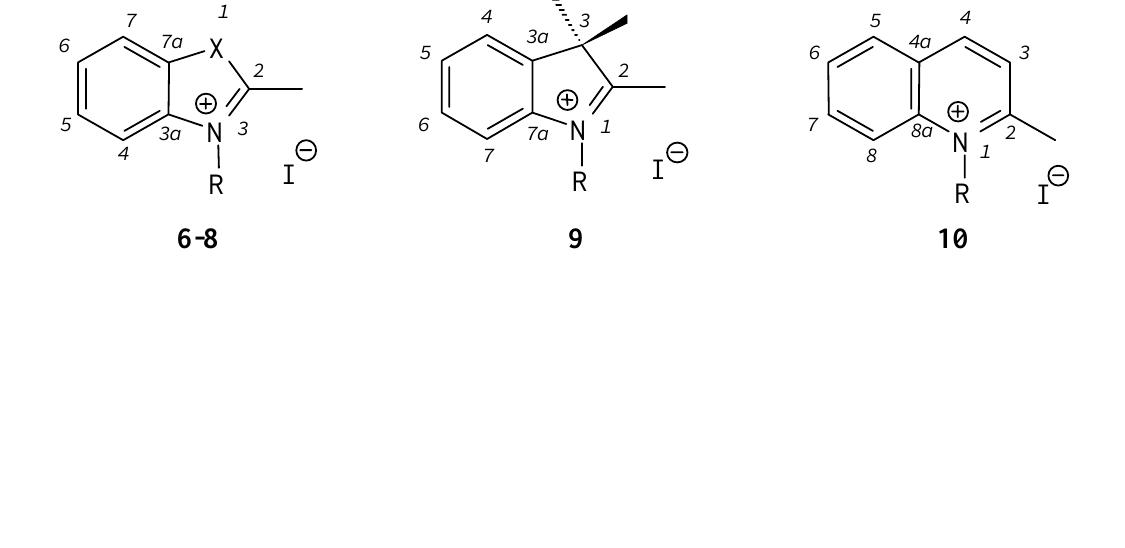
Table 3. Aromatic 1 H-NMR spectral data of quaternary ammonium salts 6 - 10 (DMSO-d